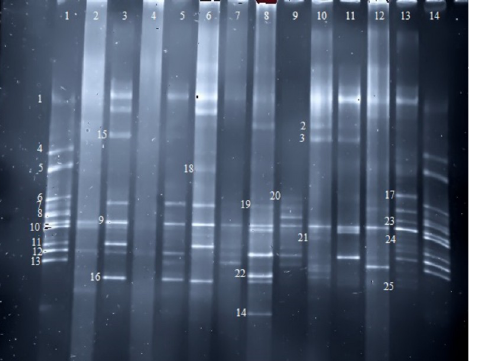
Fig 1. DGGE of PCR product; any band shows any bacterial genus or species. This method identified a greater number of bacteria than the cultural method. Sequencing detected B5, B6, S5, S6 etc. bands in DGGE method (not culture). Bacteria numbers: 1(Bacteroides), 2(B5), 3(B6), 4(Bifidobacterium), 5(Staphylococcus), 6 (Peptostreptococcus), 7(Actinomyces), 8(Lactobacillus), 9(Streptococcus), 10(Micrococcus), 11(Prevotella), 12